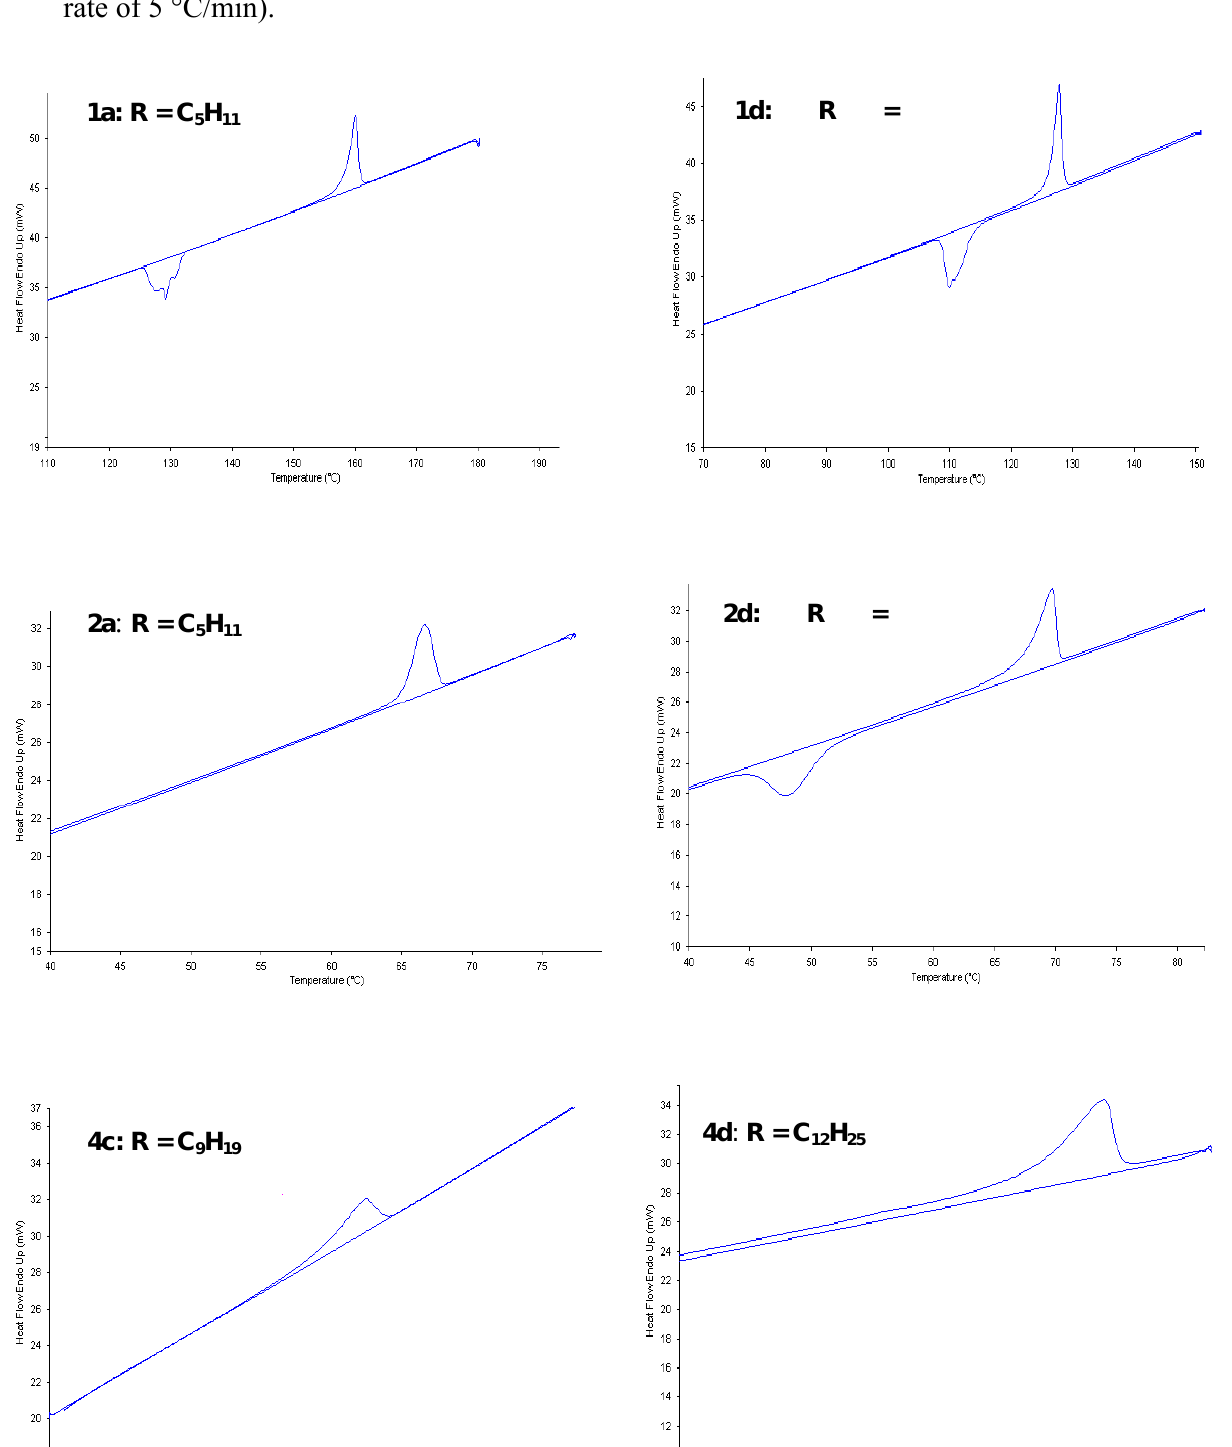
Figure 1. DSC traces for compounds 1a , 1d , 2a , 2d , 4c and 4d (second heating cycle at a rate of 5